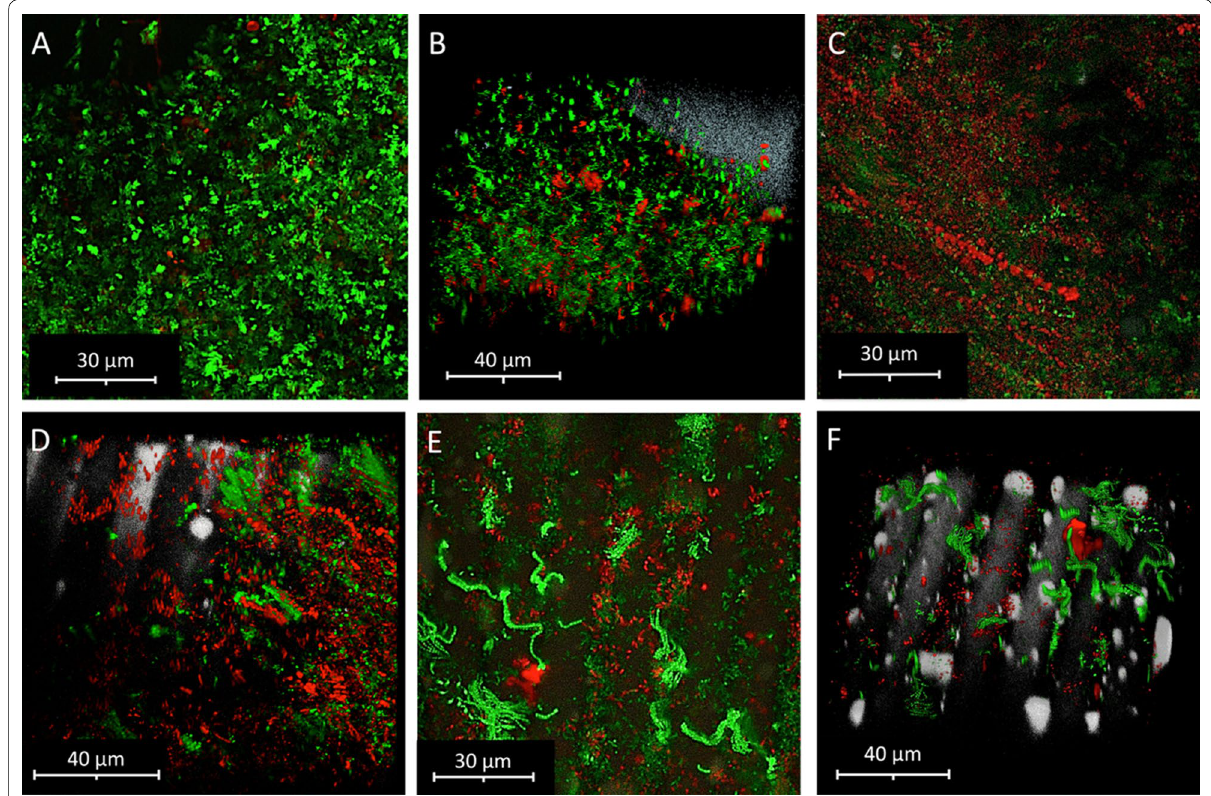
Fig. 3 Micrographs of differential staining and confocal laser scanning microscopy. A , B Untreated controls; C , D Maltodextrin-treated samples; E , F Maltodextrin/2IB3MP-treated samples. Living bacteria are shown in green, while dead cells are depicted in red. The grey structures in the back- ground are fibers of the textile that was used for the